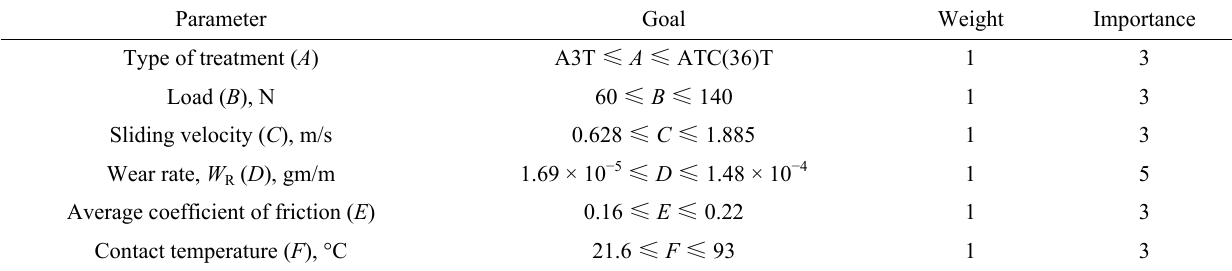
Table 15 Optimization results for the tribological parameters. S. No.